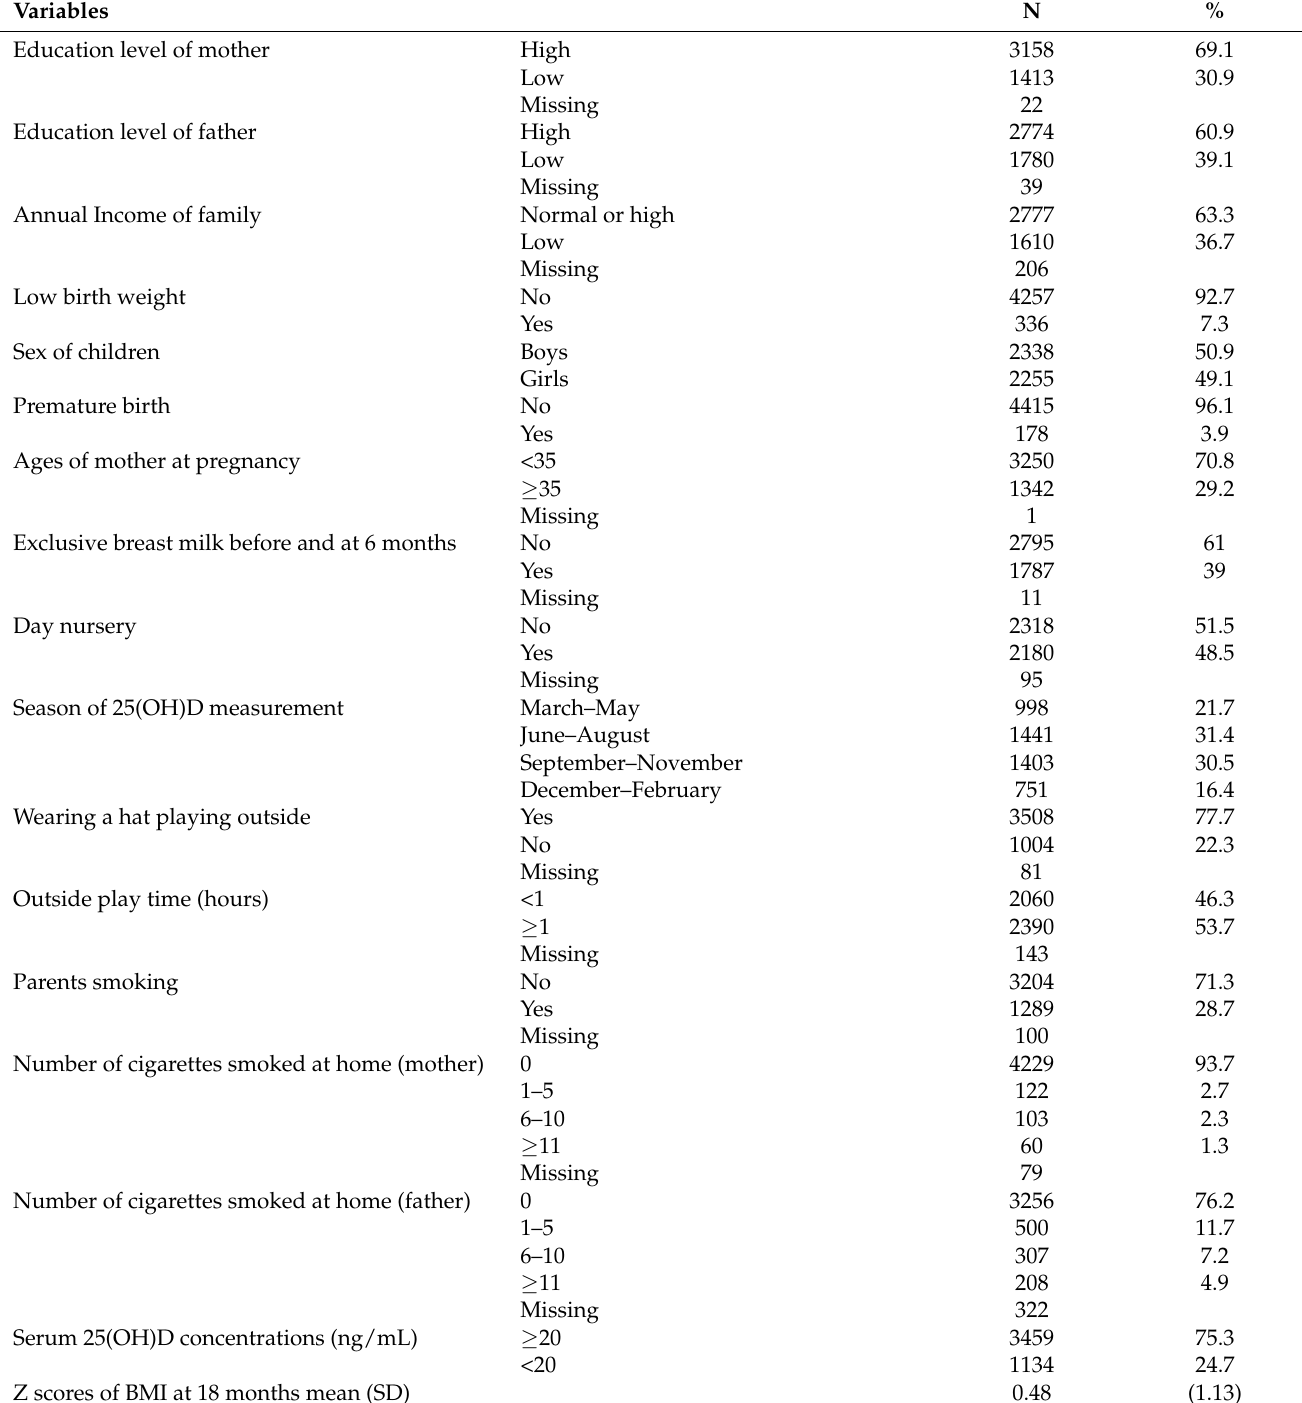
Table 1. Baseline characteristics of